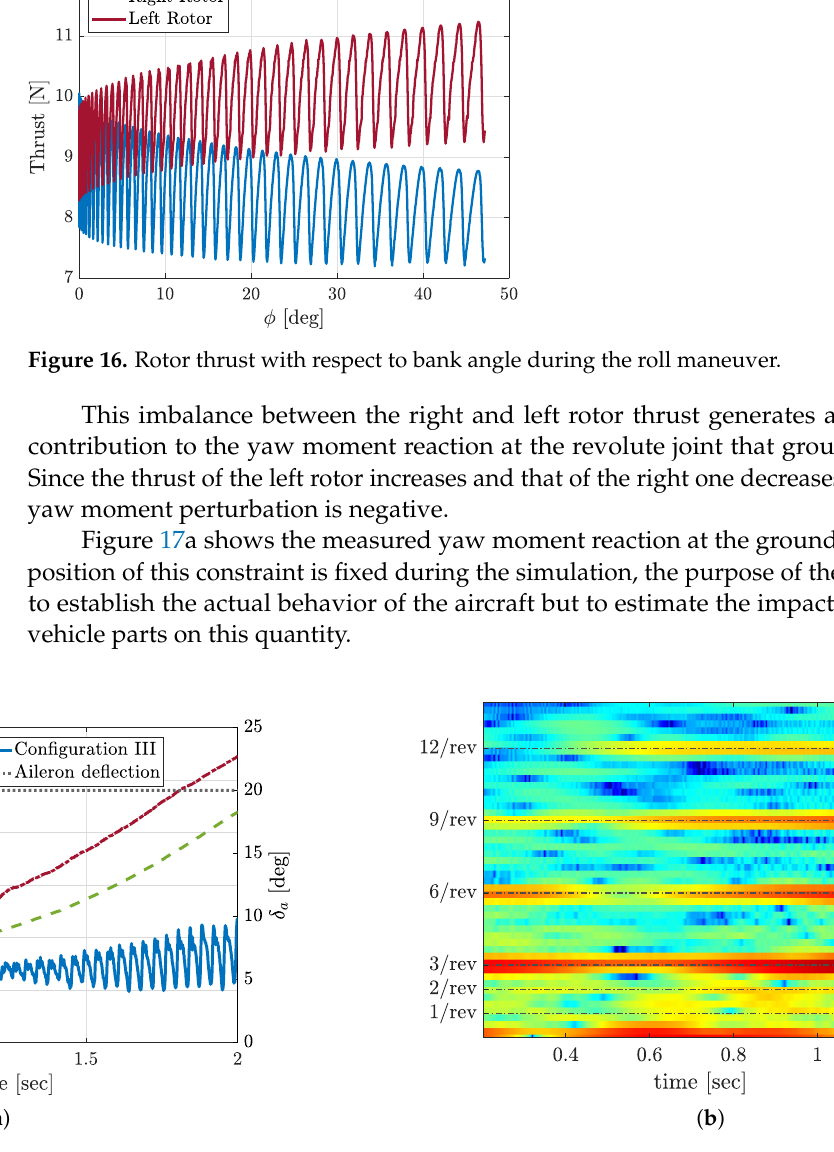
Figure 17. Yaw moment during the roll maneuver. ( a ) Yawing moment reaction evolution during roll. ( b ) Spectrogram of yaw moment time history for